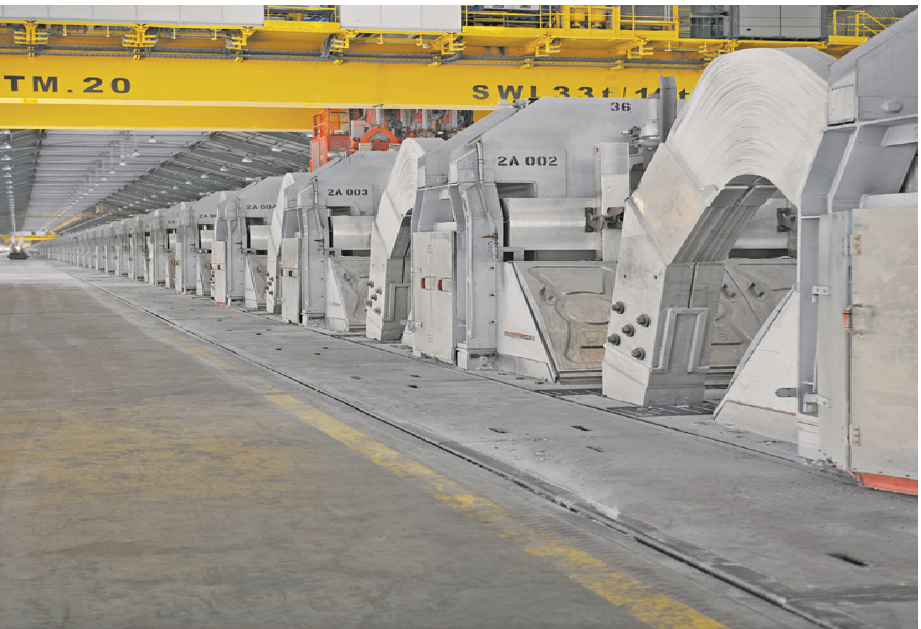
Figure 1. System’s working environment characterised by a high magnetic field up to 300–500 Gauss, ambient temperature up to 60 ◦ C, high pot shell temperature varying between 120 ◦ C and 500 ◦ C, high relative humidity up to 100%, and concrete debris on the